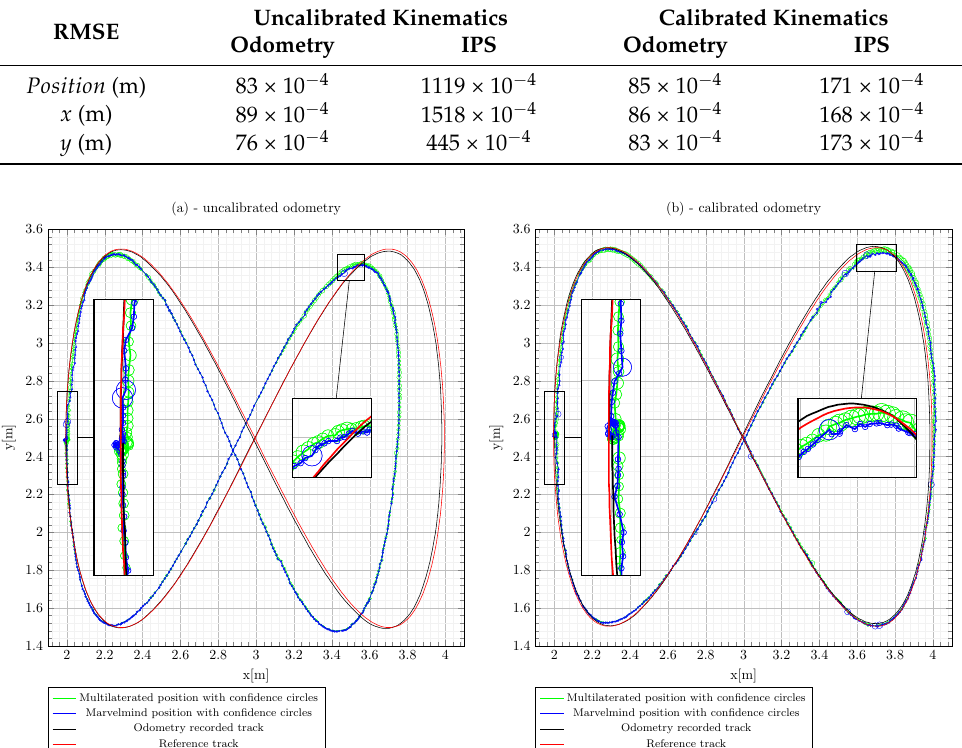
Multilaterated position with confidence circles Marvelmind position with confidence circles Odometry recorded track Reference track Figure 16. Lissajous-curve-shaped trajectory tracking before ( a ) and after ( b ) kinematics